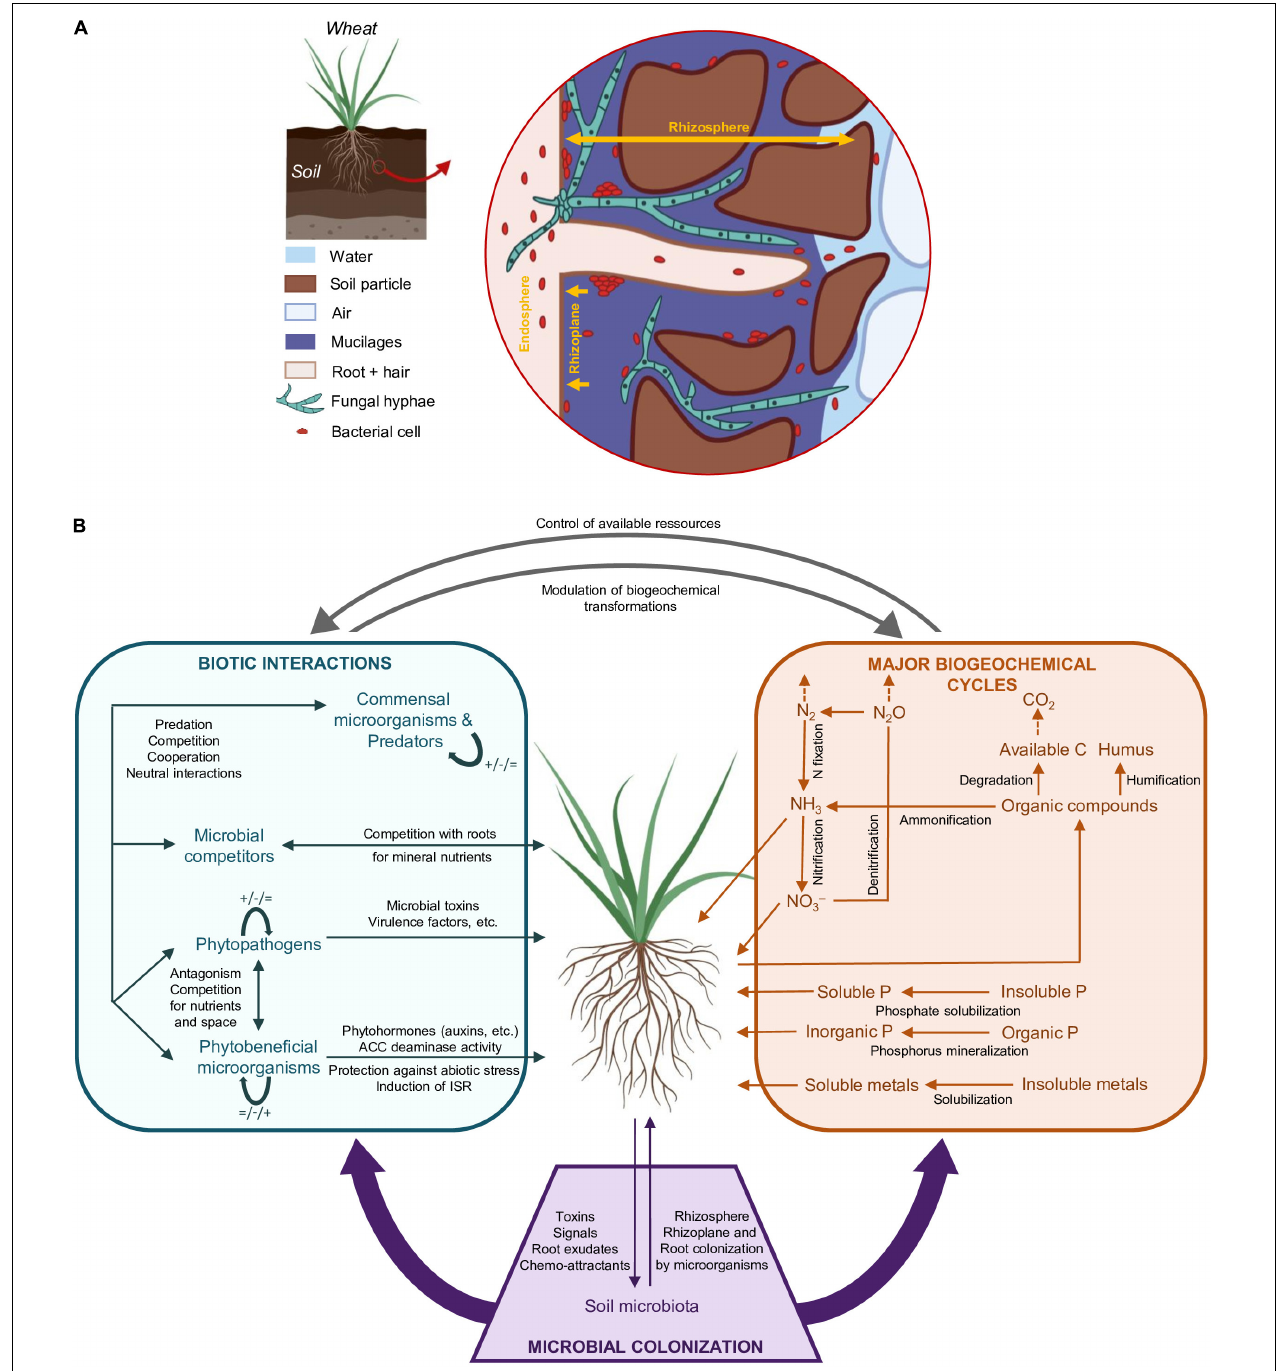
FIGURE 1 | Relationship between wheat roots and soil/microbial components. (A) Structure of the rhizosphere, rhizoplane, and endosphere (not to scale). The rhizosphere is the soil in the immediate vicinity of the root, where the root has a major direct impact on soil organization and microbial functioning. The rhizoplane is the interface between the root surface and the soil. The endosphere corresponds to root internal tissues. Adapted from York et al. (2016) and Ding et al. (2019). (B) Major root-level microbial contributions to biotic interactions and biogeochemical cycles linked to plant growth and health. Root colonization by microorganisms is mediated by plant signals and exudates, which attract or repel soil microorganisms. Biotic interactions in the rhizosphere include plant-microorganism interactions and microorganism/microorganism interactions, with beneficial (+), deleterious (-) or neutral effects ( = ). Major microbial transformations are indicated for C, N, and P biogeochemical cycles. Metal biotransformations are not reviewed. A particular microbial taxon may be involved in several different biotic interactions (left box) and biotransformations (right box). ISR, Induced Systemic Resistance; ACC, 1-AminoCyclopropane-1-Carboxylate. Dashed arrows are used for abiotic volatilization